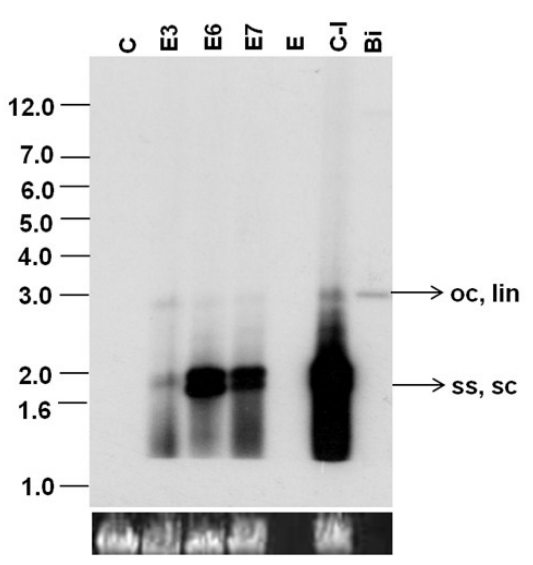
Figure 6. Southern blot analysis of transgenic Nicotiana benthamiana plants agroinoculated with SLCMV-[Attur2] DNA A and DNA B partial dimers. DNA (1 µg) from control uninfected (C), control agroinoculated (C-I), and the three agroinoculated transgenic plants (E3, E6, E7) was loaded in the respective lanes. Bi: SLCMV-[Attur2] full-length DNA A (50 pg) was used as a positive control. [α- 32 P]dCTP-labeled full-length SLCMV-[Attur2] DNA A was used as the probe. Single-stranded (ss), supercoiled (sc), open circular (oc) and linear (lin) forms of viral DNA are marked. E: empty lane. The bottom panel represents equal loading of plant DNA (1 µg) in all